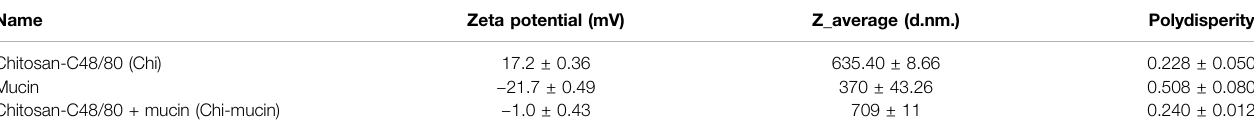
TABLE 2 | Summary table of particle characteristics of Chi, mucin, and Chi + mucin.